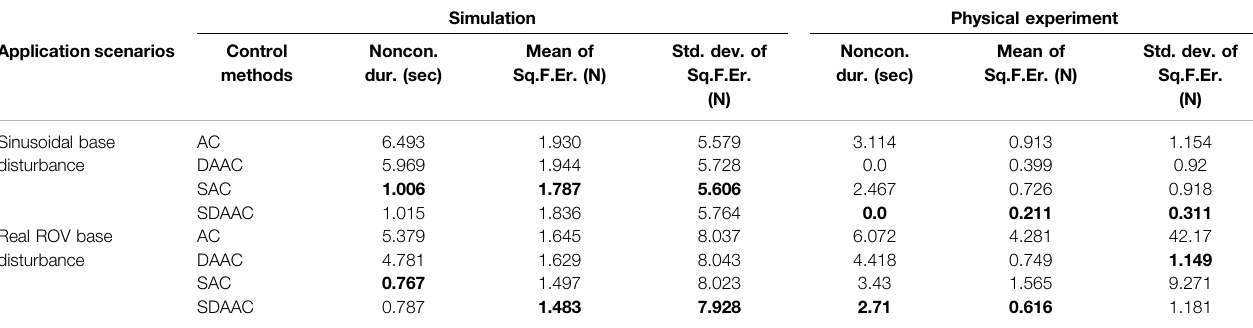
TABLE 1 | Mean and standard deviations of the squared force errors on Z direction and the total duration of contact loss in between the fi rst contact and the end of the trajectory for four controllers in two application scenarios. Four controllers are compared both in simulation and in the physical experimental set, in each case with